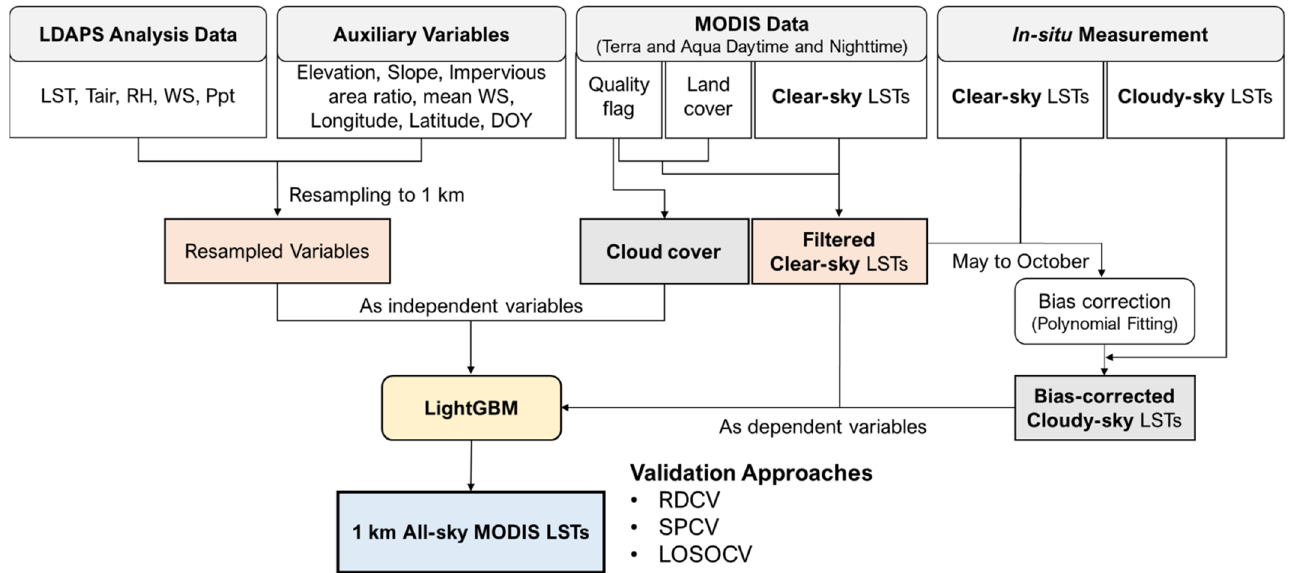
Figure 2. Flowchart of the LightGBM-based all-sky 1 km MODIS LST reconstruction model proposed in this study.